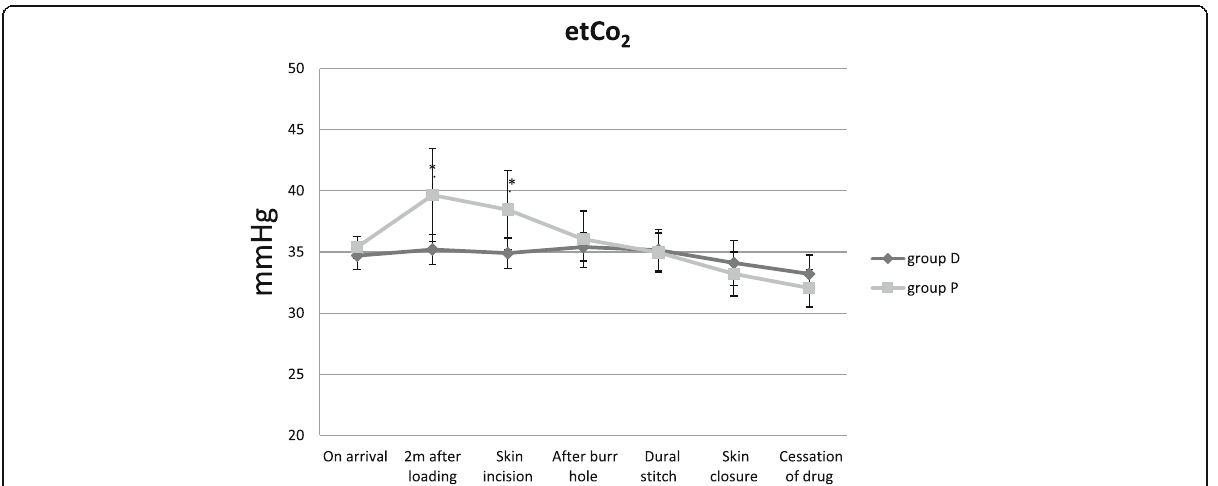
Fig. 6 Changes etCo 2 . Changes in mean values of etCO 2 over time. Lines are mean etCO 2 and error bars are SD. *Statistical significance between groups